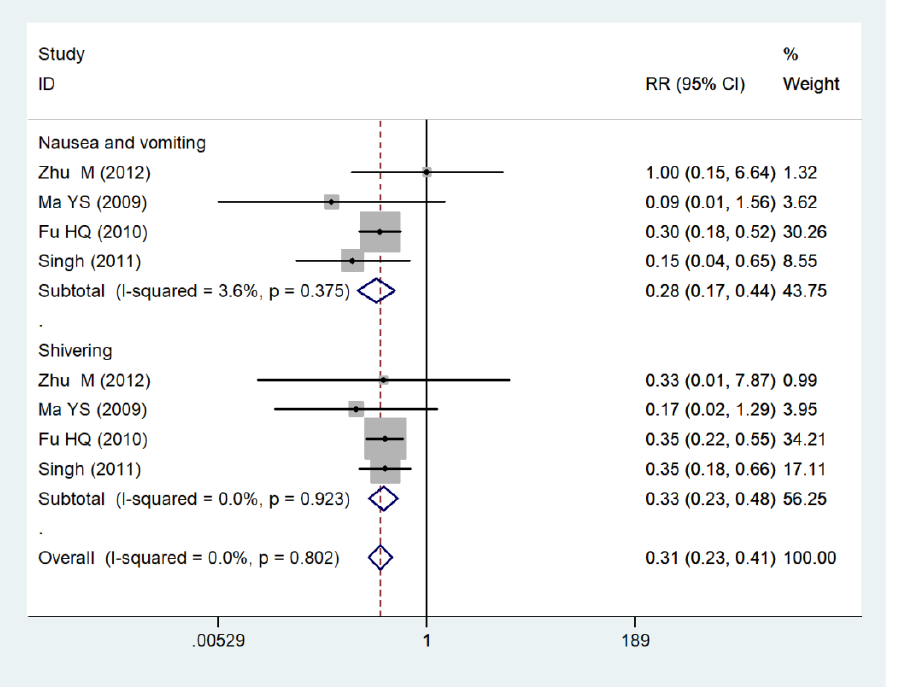
Figure 4: A forest plot of postoperative nausea/vomiting and shivering incidence between 5-hydroxytryptamine 3 receptor antagonists and control groups according to the pain degree. (RR, risk ratio).